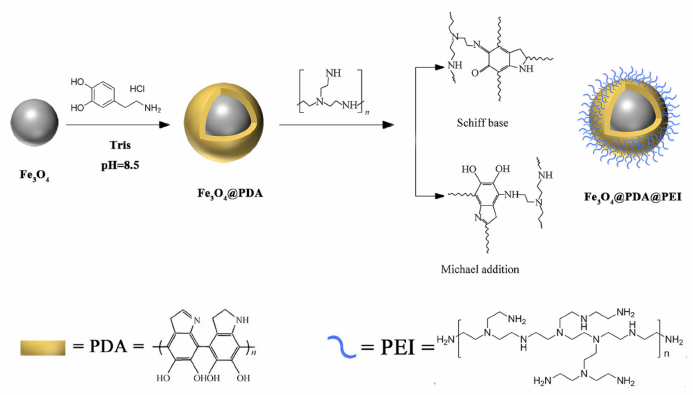
Figure 1. Schematic diagram of Fe 3 O 4 @PDA@PEI MBs preparation process.